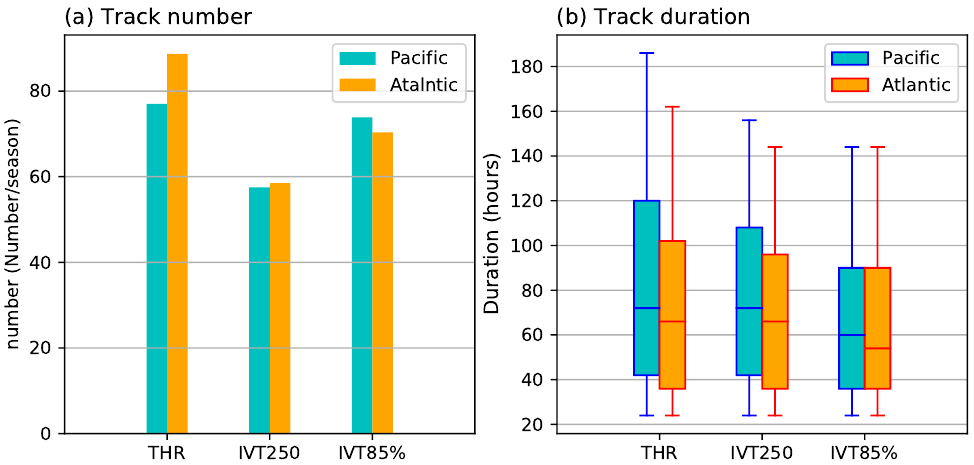
Figure 3. ( a ) average number of AR tracks per cool season in the North Pacific (cyan) and North Atlantic (orange) as found by THR, IVT250ano and IVT85% methods. ( b ) Box-whisker plots of track durations (in hours) for the North Pacific (cyan) and North Atlantic (orange) ARs. Box ends denote the inter-quantile-range of the distribution, with the median as the line in the middle. Box whiskers denote the 5th and 95th